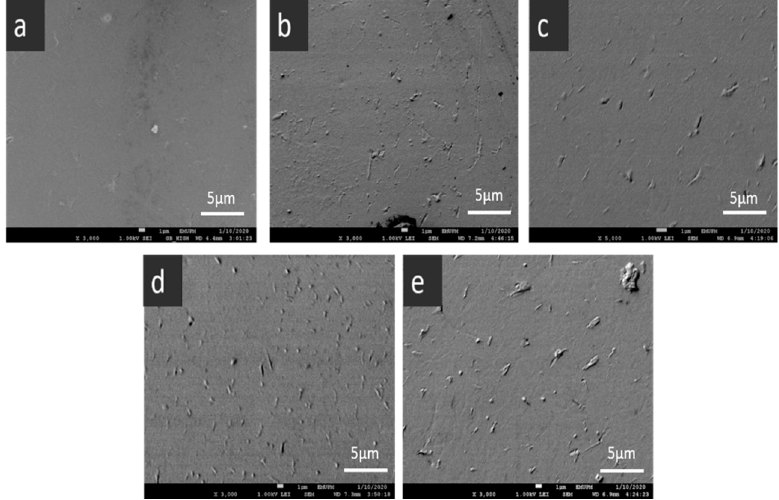
Figure 1. FESEM images of PLA/PBS composites, ( a ) N1, ( b ) N2, ( c ) N3, ( d ) N4and ( e ) N5.